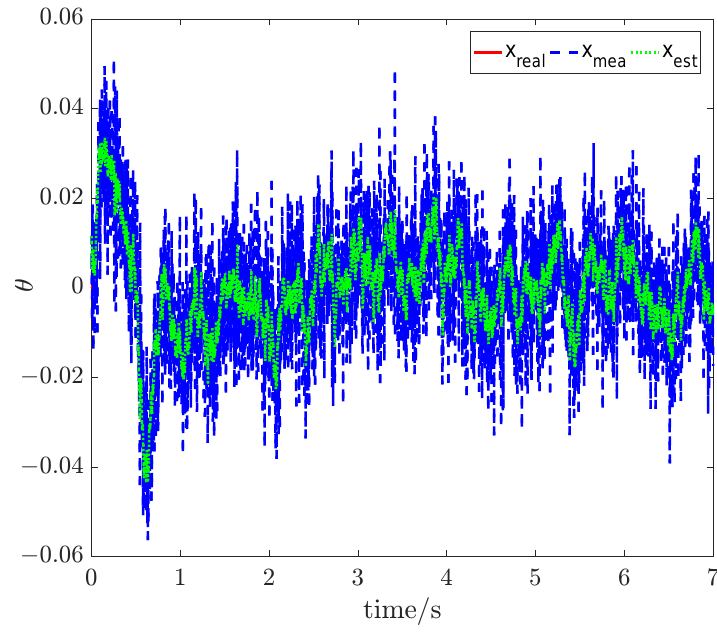
Figure 15. Signal θ